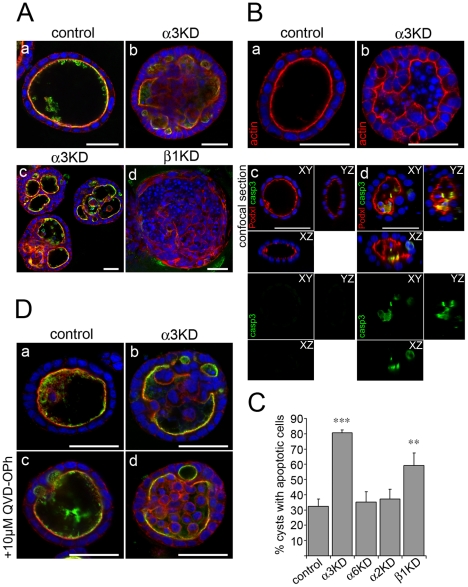
BME-embedded Itgα3-KD MDCK cysts can form lumens via apoptotic cavitation.A) Control, Itgα3- and Itgβ1-KD MDCK cells were grown in 3D BME-gels for 15 days. Cysts were fixed and stained for filamentous actin (TRITC-phalloidin, red), an apical marker (podocalyxin (Podxl), green) and nuclei (DAPI, blue). B) Upper panel: Control and Itgα3-KD MDCK cells were grown in 3D BME-gels for 7 days. Cysts were fixed and filamentous actin was stained using TRITC-phalloidin (red). Lower panel: Cysts were fixed and stained for an apical marker podocalyxin (Podxl, red) and for an apoptosis marker cleaved caspase-3 (green). In both panels nuclei were stained using DAPI (blue). C) Quantitation of cysts with apoptotic cells in the lumen. Control, Itgα3- Itgα6-, Itgα2- and Itgβ1-KD MDCK cells were grown in 3D BME gels for 7 days, fixed and stained for filamentous actin and nuclei as mentioned above. The data is shown as average +SD and is representative of 2–3 independent experiments. P-values <0.01 are signified by (**) and ≤0.001 by (***). D) Control and Itgα3-KD cells were grown in 3D BME gels for 7 days in the presence or absence of 10 mM apoptosis inhibitor QVD-OPh. Cells were fixed and stained for podocalyxin (Podxl, green), filamentous actin (red) and DNA (blue). Size bars are 30 µm.